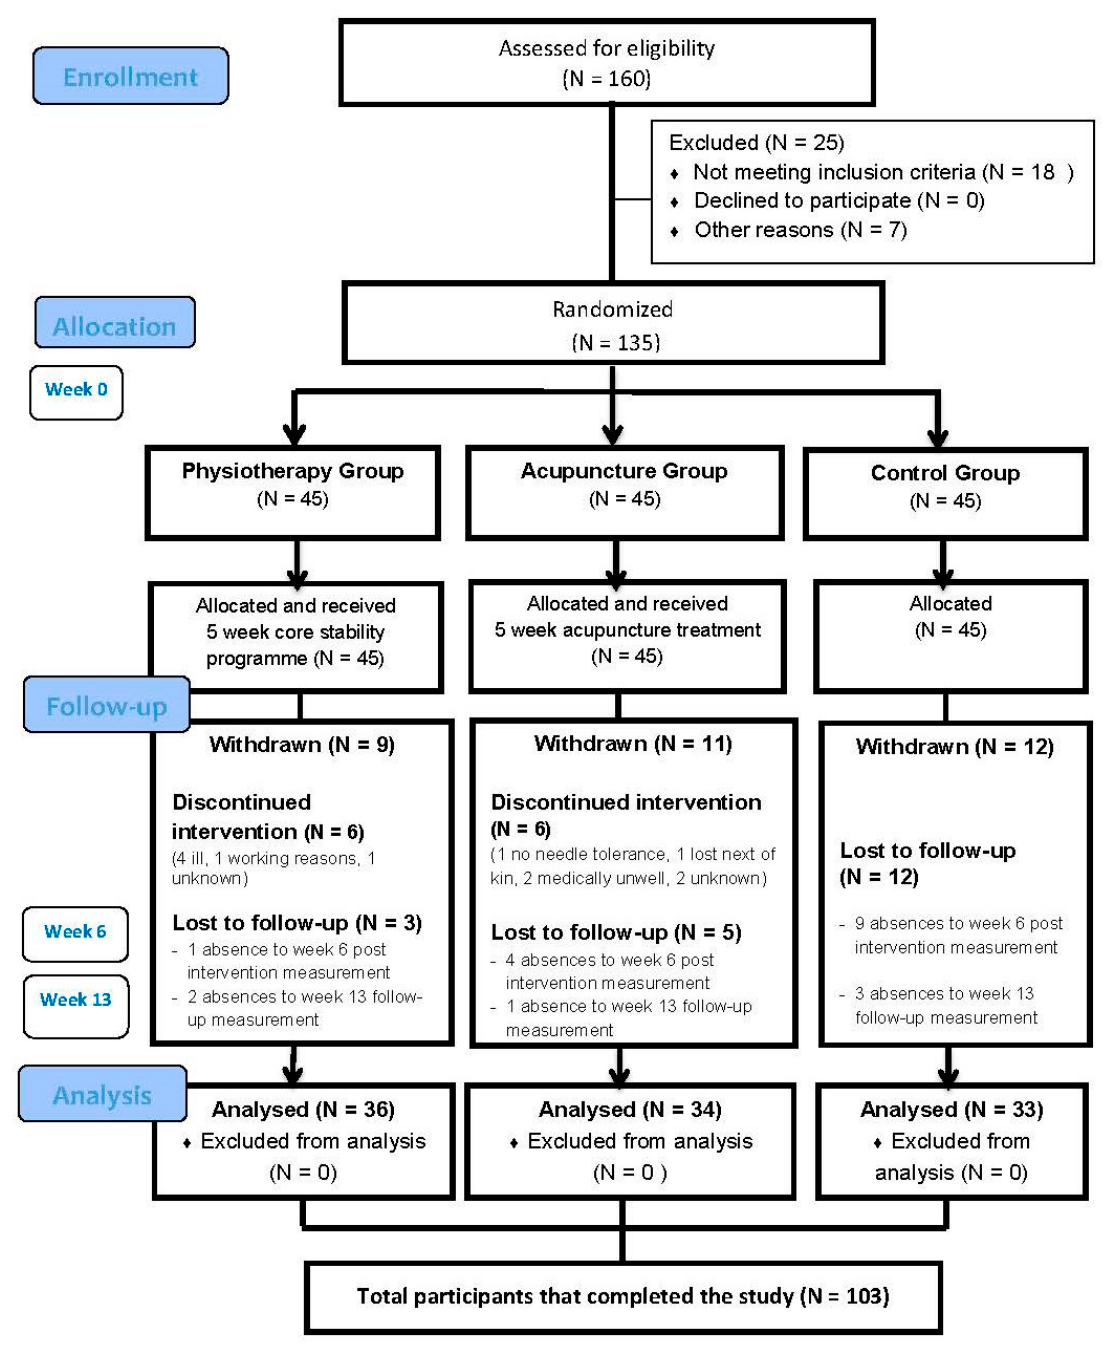
Figure 1. CONSORT flow diagram of study participation.